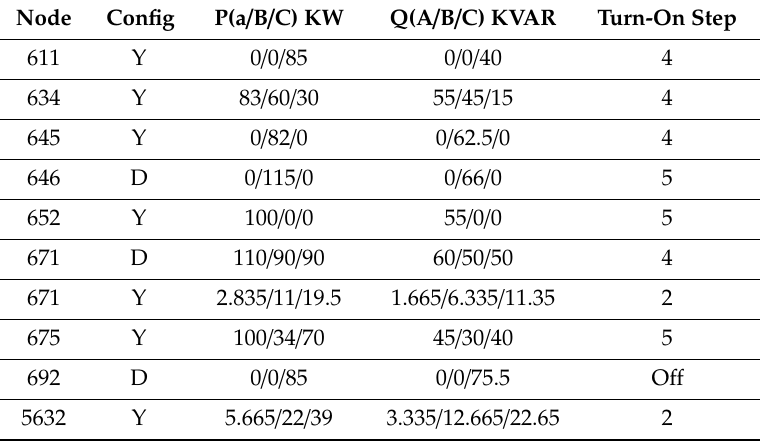
Figure 11. Restoration Sequence Result, with ( a – e ) representing step 1, 2, to 5 respectively. Table 3. Load Details and Restoration